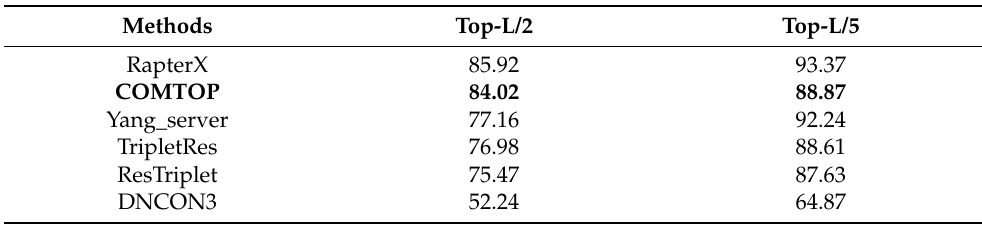
Table 5. Comparison of COMTOP model performance with a few state-of-the-art systems for 20